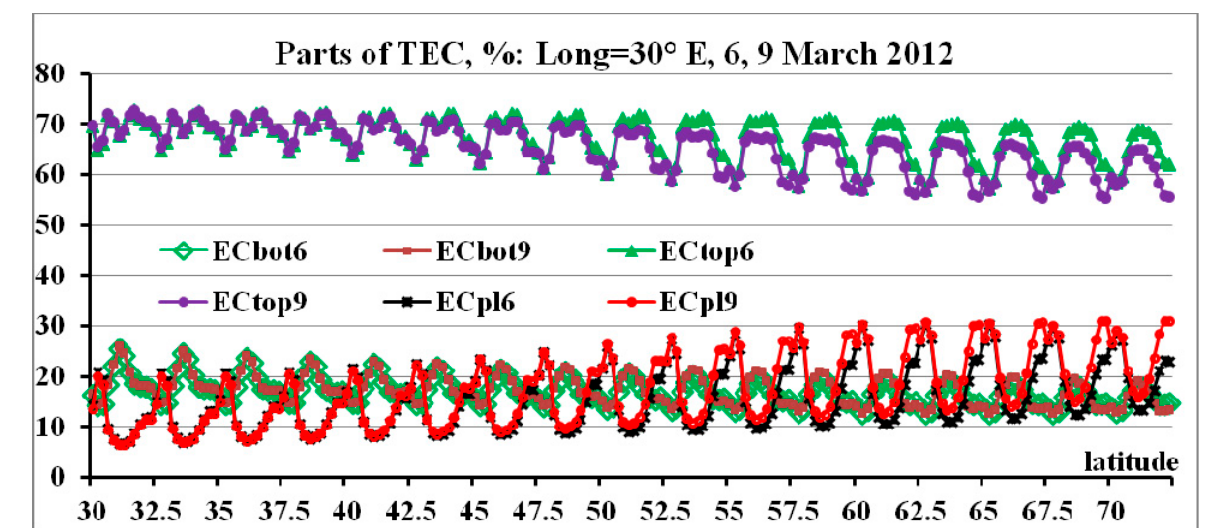
Figure 9. Contributions of bottomside, topside and plasmaspheric parts to the total TEC